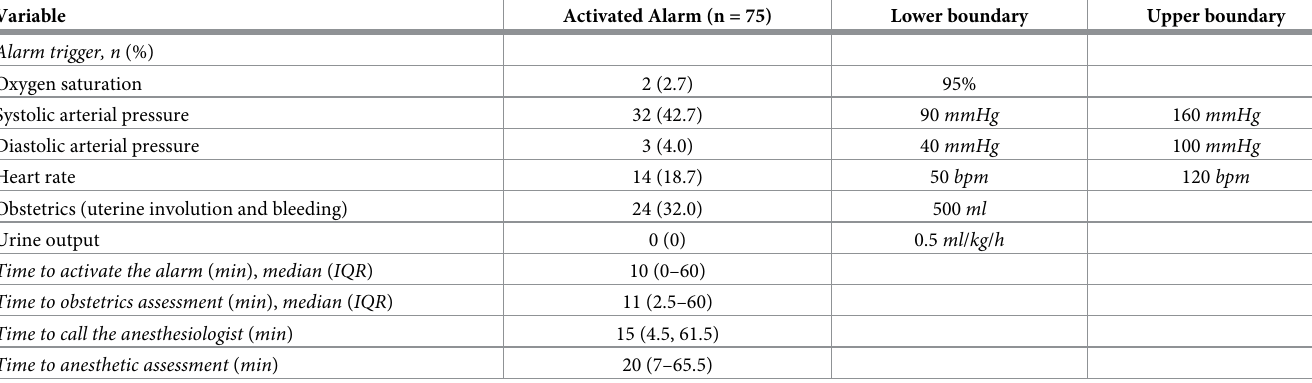
Table 2. Causes of MEWS activation, parameter ranges, and time to assessment.